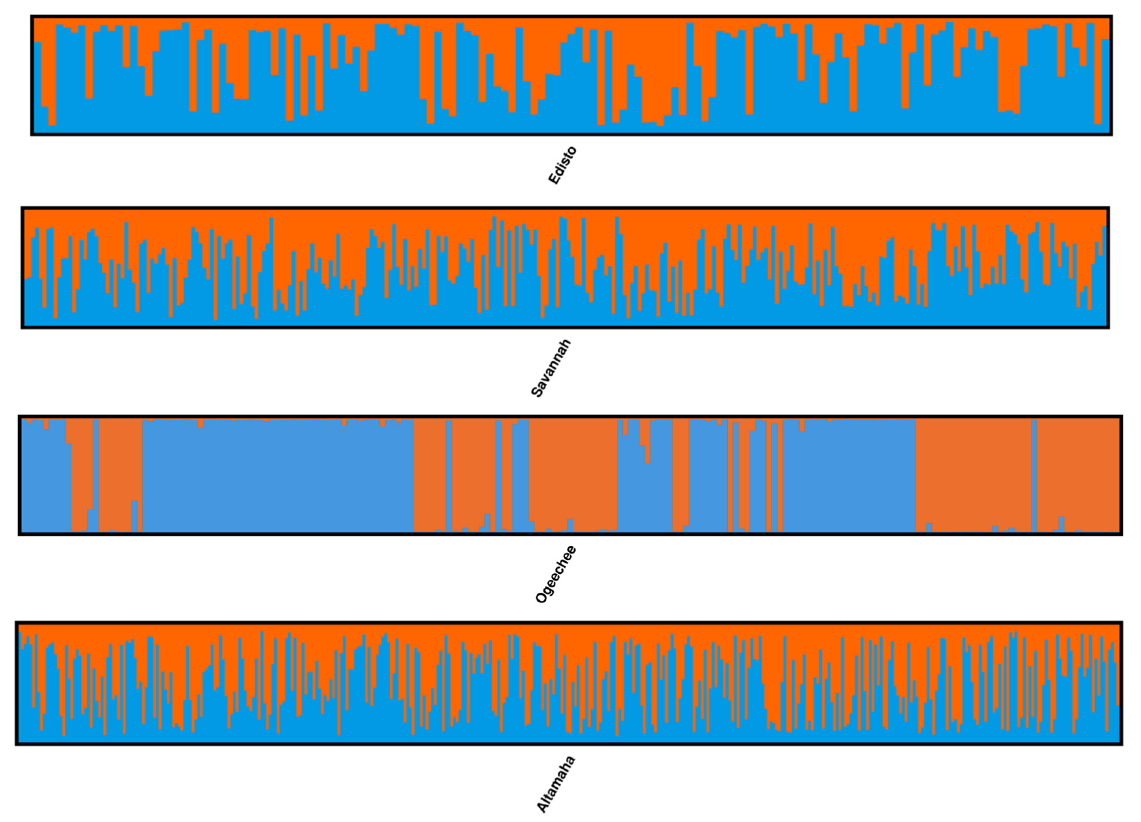
Figure 4. STRUCTURE analysis of the population structure of Atlantic sturgeon specimens from each of the Edisto, Savannah, Ogeechee, and Altamaha rivers individually with K = two based on microsatellite analysis at 11 loci. Each vertical bar represents a single individual, and different colors represent the contribution of each K genetic cluster to each specimen’s genotype.